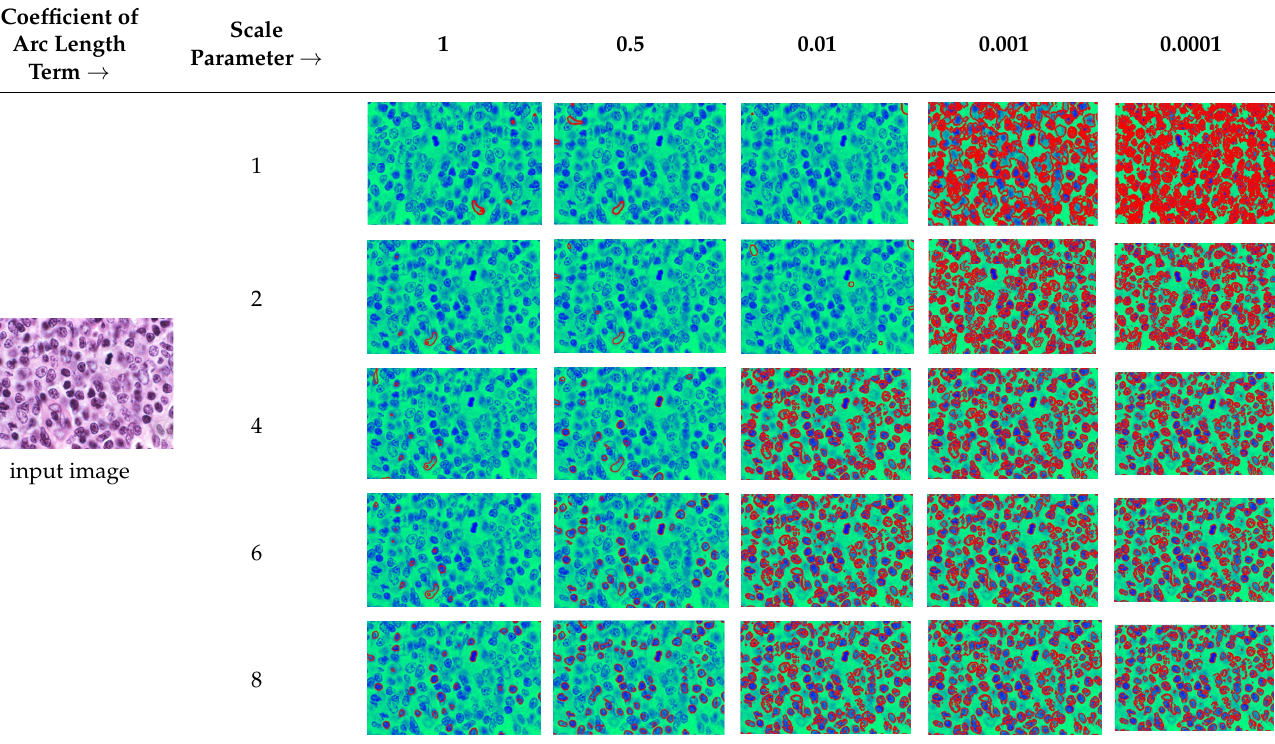
Table 2. Simulation of parameters.